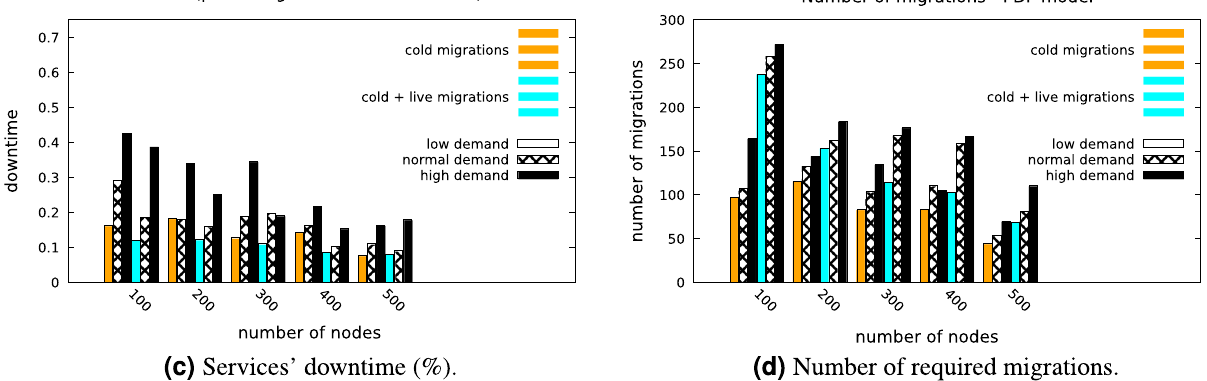
Figure 7. Services’ downtime and number of required migrations for the constant probability model ( a, b ) and for the PDF model ( c, d ).